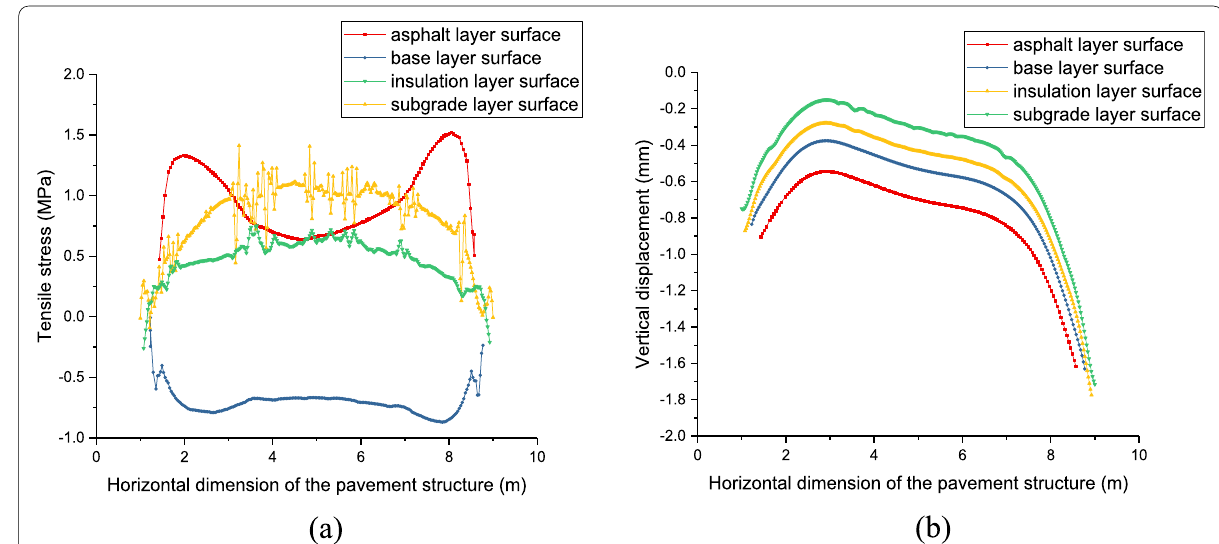
Fig. 10 a The tensile stress and b the vertical displacement in the pavement structure with polystyrene insulation layer on March 1st, 2017 at Anchorage,